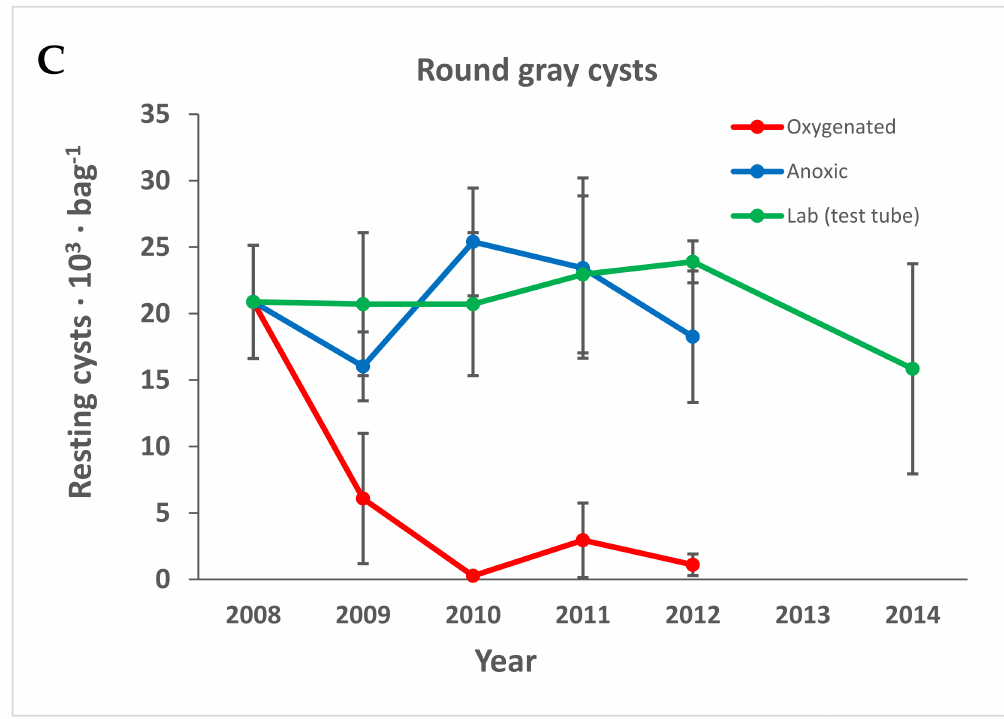
Figure 5. The resting cysts divided into groups depending on fossilizability according to the literature: ( A ) fossilizable; ( B ) non-fossilizable; ( C ) round gray cysts. Error bars are the standard error of the mean. Species are divided into groups as shown in Table 1.